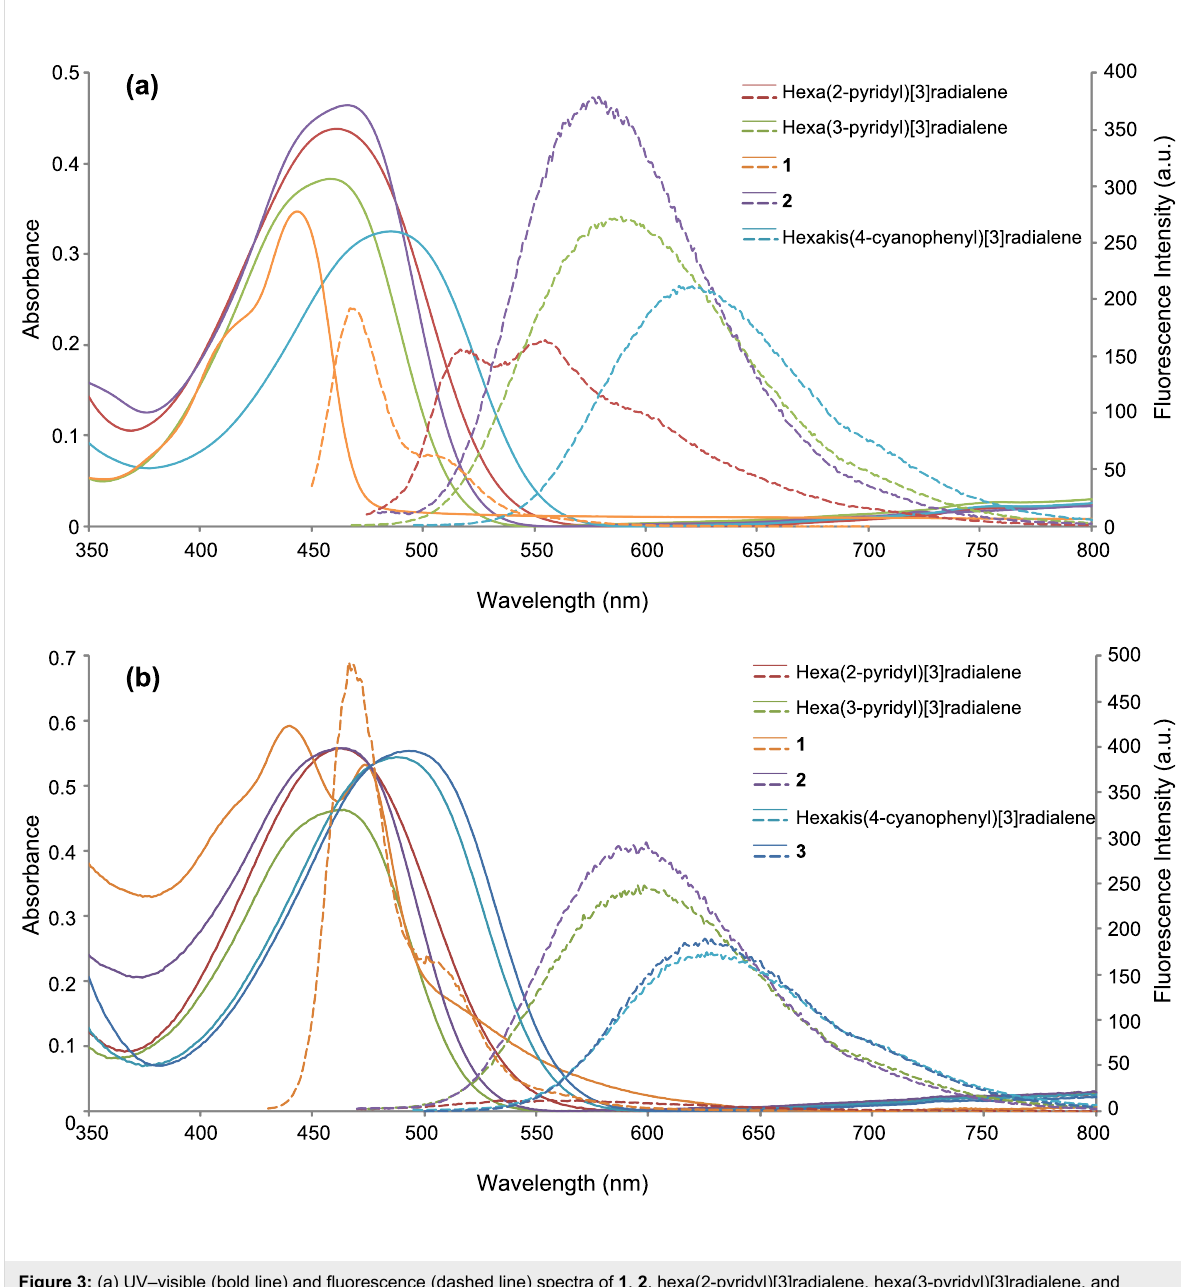
Figure 3: (a) UV–visible (bold line) and fluorescence (dashed line) spectra of 1 , 2 , hexa(2-pyridyl)[3]radialene, hexa(3-pyridyl)[3]radialene, and hexakis(4-cyanophenyl)[3]radialene in dichloromethane. (b) UV–visible (bold line) and fluorescence (dashed line) spectra of 1 , 2 , 3 , hexa(2- pyridyl)[3]radialene, hexa(3-pyridyl)[3]radialene, and hexakis(4-cyanophenyl)[3]radialene in